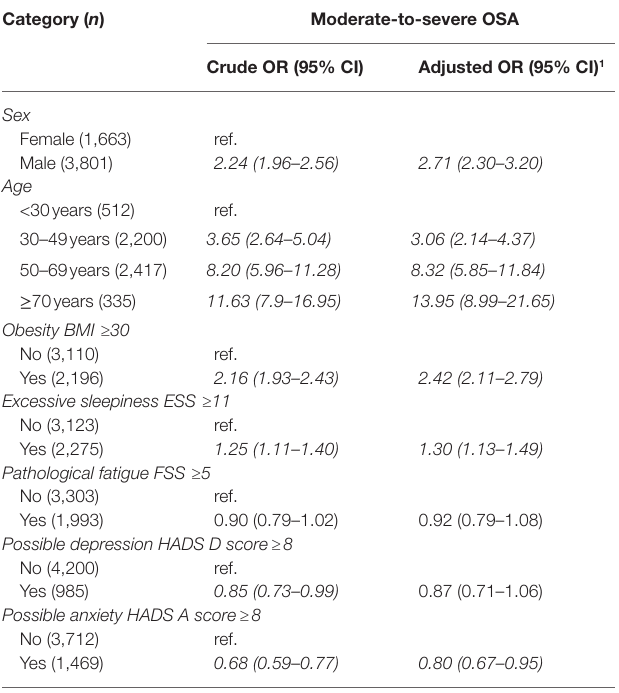
TABLE 3 | Logistic regression analyses with moderate-to-severe obstructive sleep apnea [OSA with apnea–hypopnea index/respiratory event index